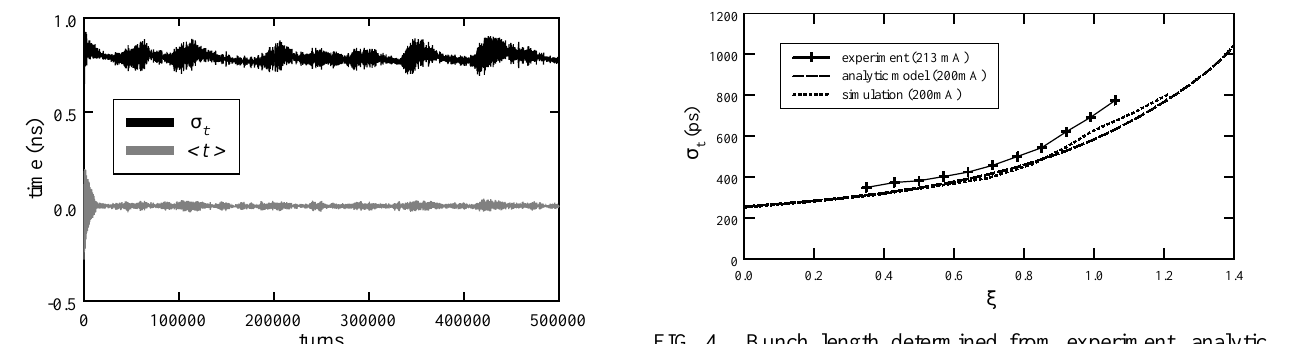
FIG. 4. Bunch length determined from experiment, analytic modeling, and simulations, for passive Landau-cavity operation with the Aladdin lattice. The parameter j is proportional to the Landau-cavity voltage, equaling unity for an optimally length- ened